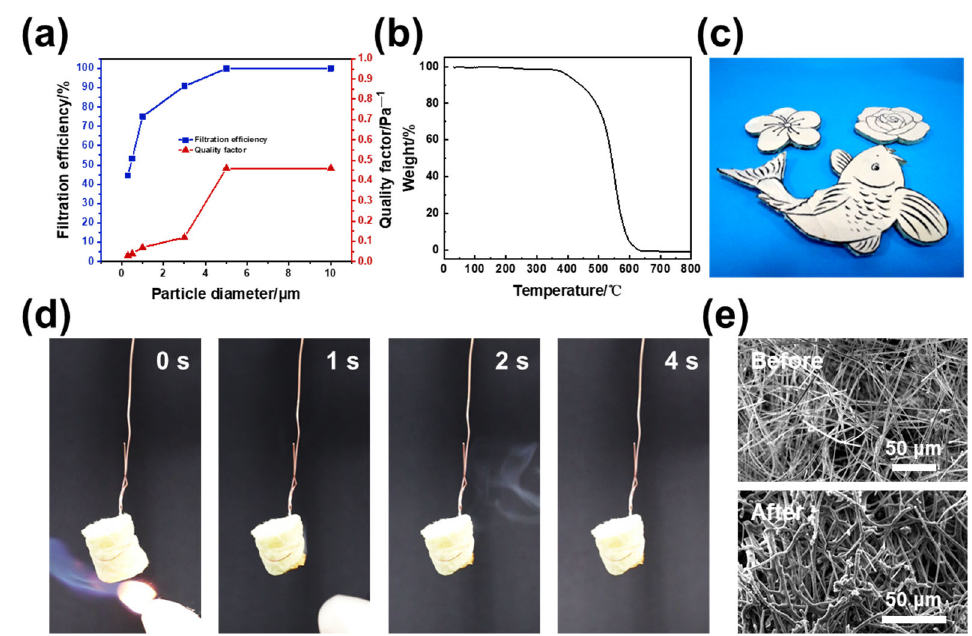
Figure 4. ( a ) Filtration efficiency. ( b ) TG curves. ( c ) An optical photograph of PAI/PBMI aerogel with diverse shapes. ( d ) Flame retardant performance demonstration. ( e ) The SEM image of PAI/PBMI aerogel before and after burning.